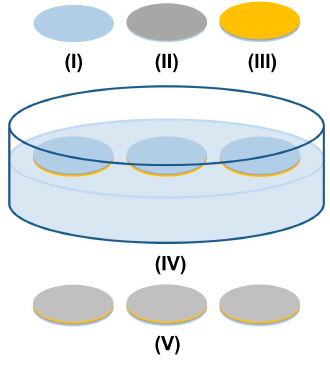
Figure 6. Schematic of synthesis of ZnO nanowire arrays using a seedless solution-based method.